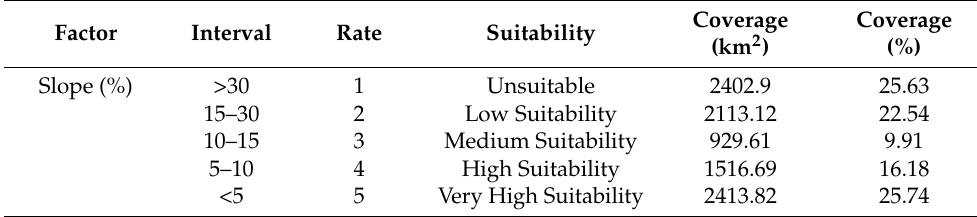
Table 3. Distribution of slope suitability